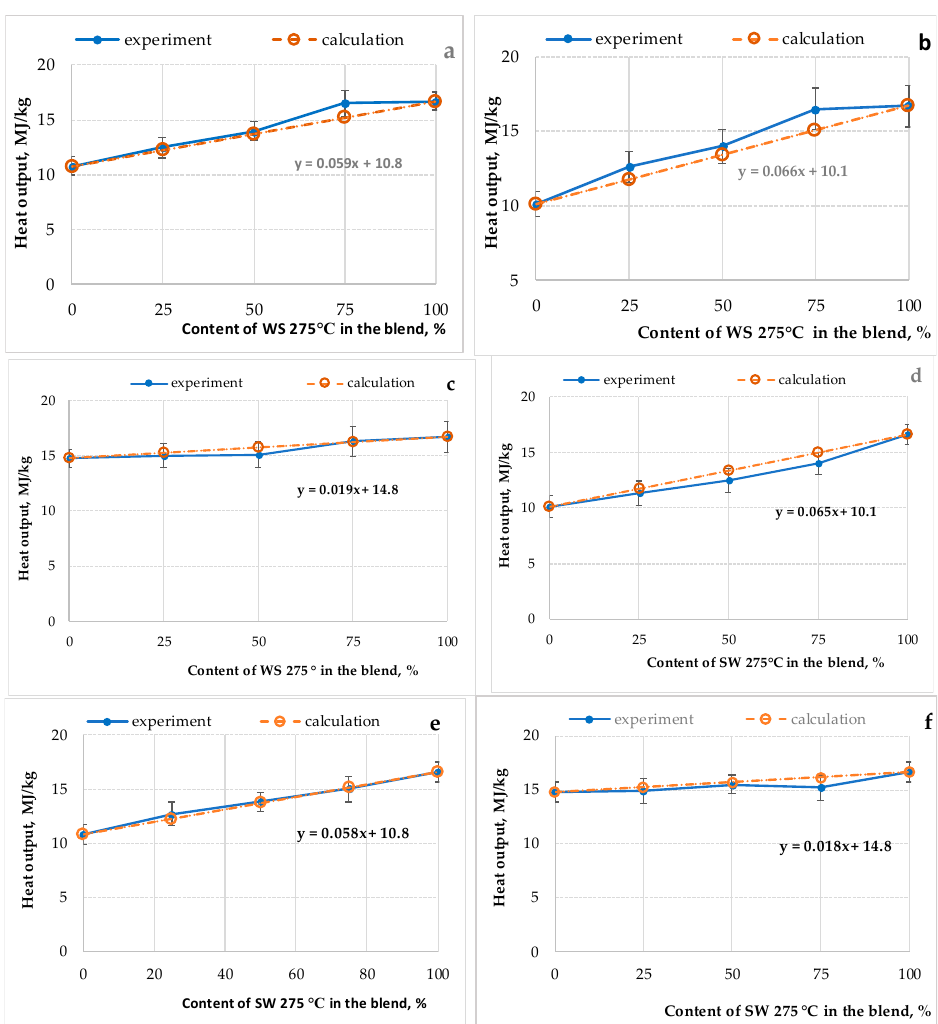
Figure 9. The experimental and calculated values of heat output of biomass blends of different origination and composition according to DSC tests: WS 275 °C-WS n.t. ( a ); WS 275 °C-SW n.t. ( b ); WS 275 °C-Peat ( c ); SW 275 °C-SW n.t. ( d ); SW 275 °C-WS n.t. ( e ); SW 275 °C-Peat ( f ).